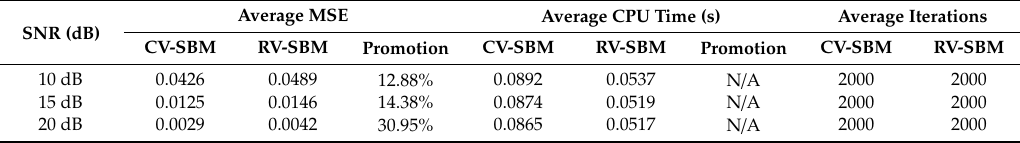
Table 3. Comparison of CV-SBM and RV-SBM when tol = 2e − 5 , k max = 2000, and n =